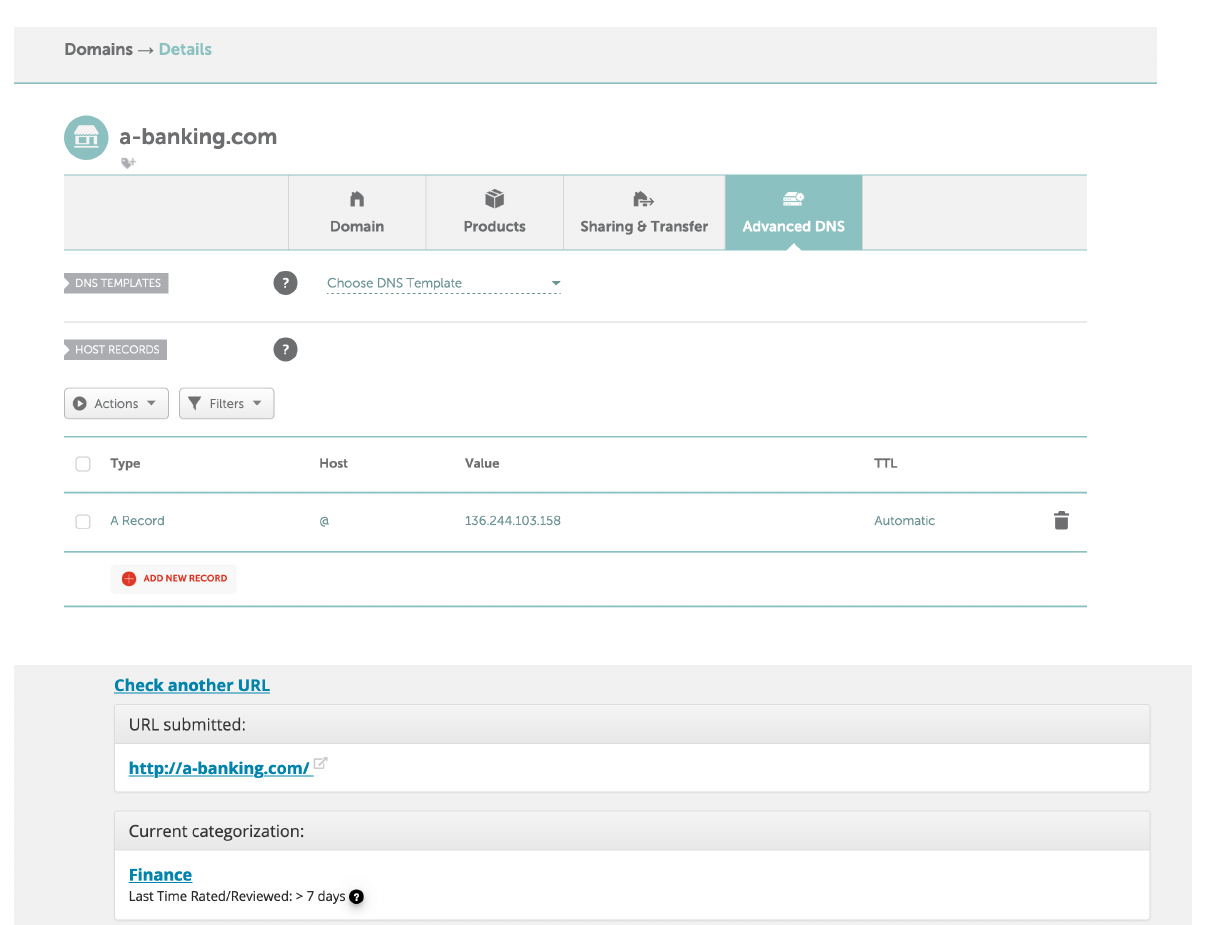
Figure 2. The domain pointing to our C2 Server ( up ) and its categorization ( down